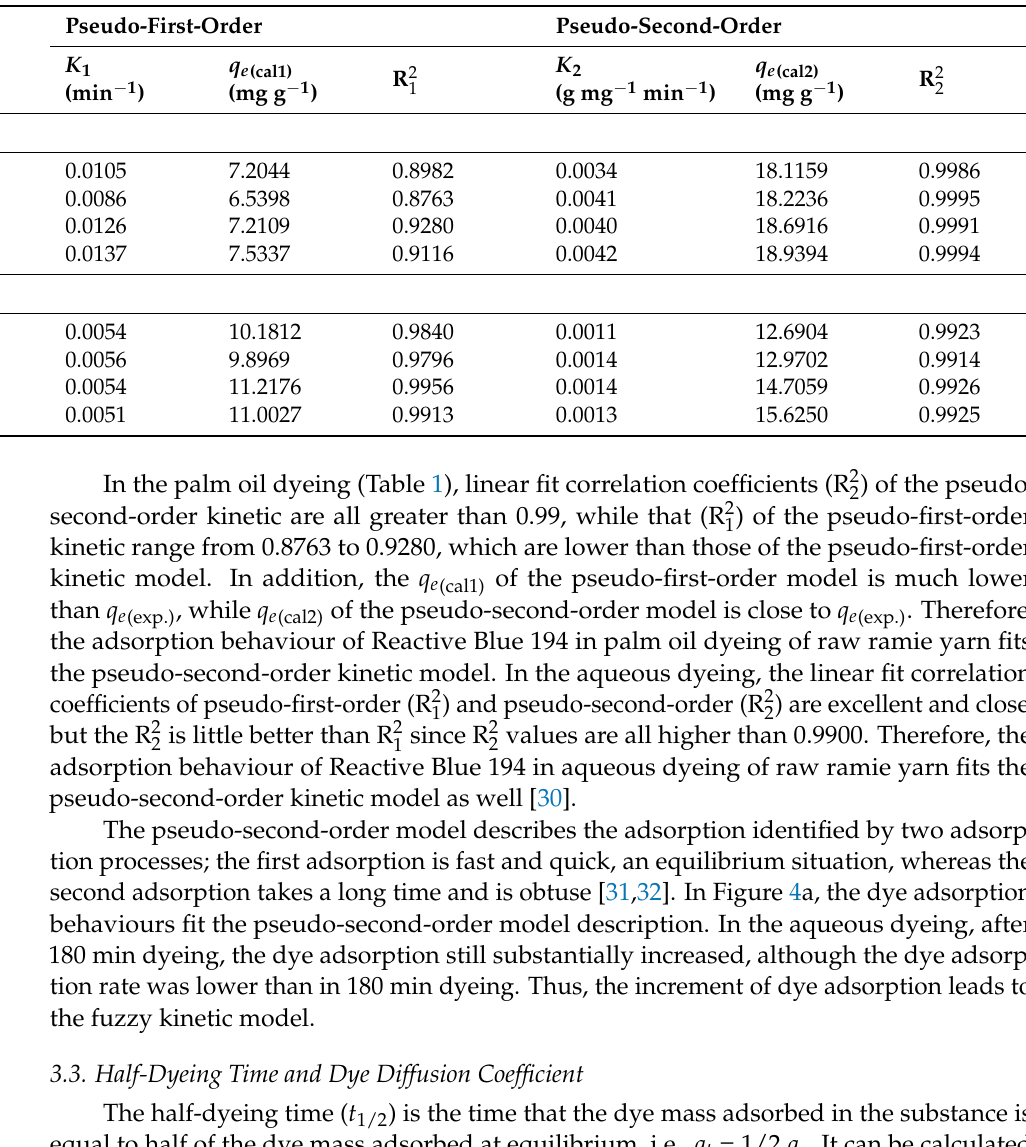
Table 1. Kinetic model of Reactive Blue 194 dyeing raw ramie